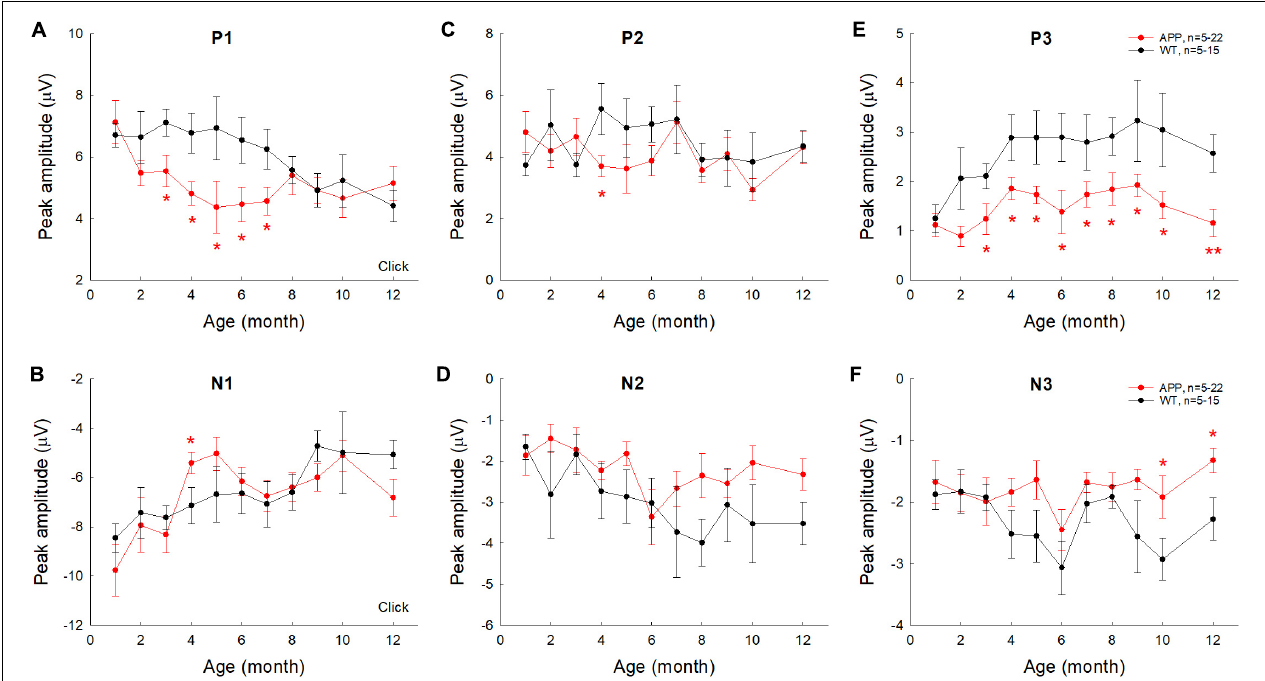
FIGURE 4 | Changes of AECP peaks in APP/PS1 AD mice with aging. WT littermates served as control. Peaks of AECP recorded from each mouse were measured and averaged. Peak name is presented at the top middle place in each panel. N is the mouse number. The amplitudes of peak P3 in AD mice are significantly less than those in WT mice after 3 months old. * p < 0.05, ** p < 0.01, t -test, two-tailed.